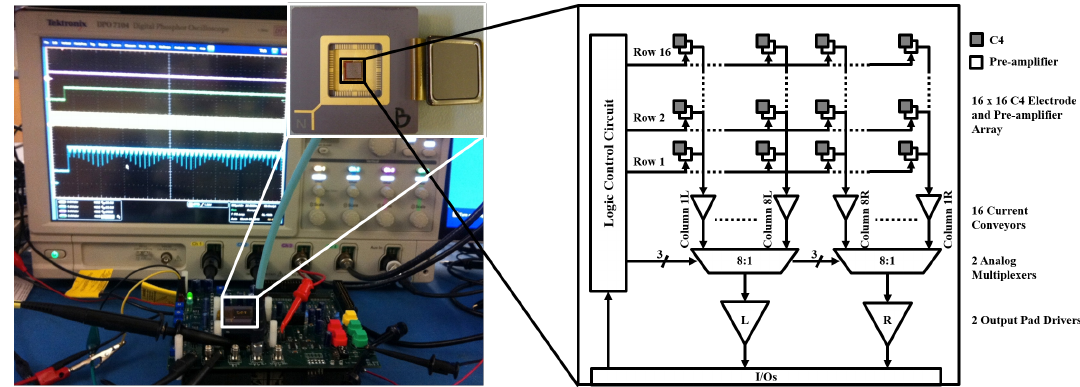
Figure 2. Neuropotential acquisition system and block diagram of the neuropotential acquisition